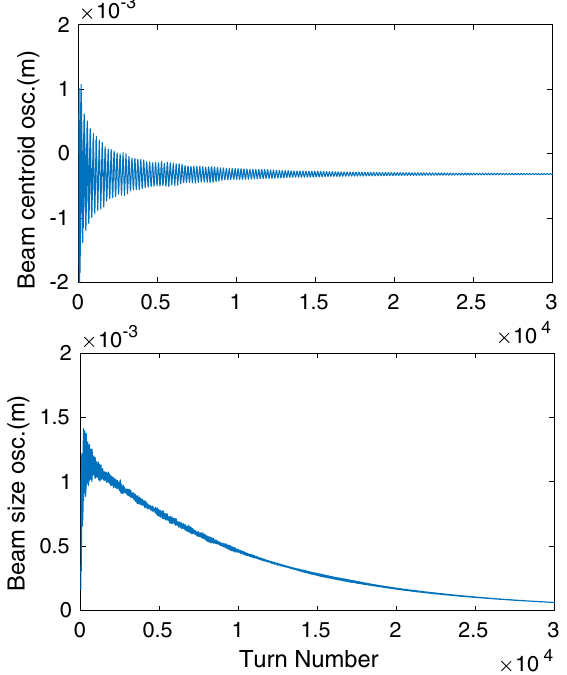
FIG. 12. Perturbations on the stored beam after the NLK injection. The upper plot is the beam centroid position and the bottom plot is the beam size